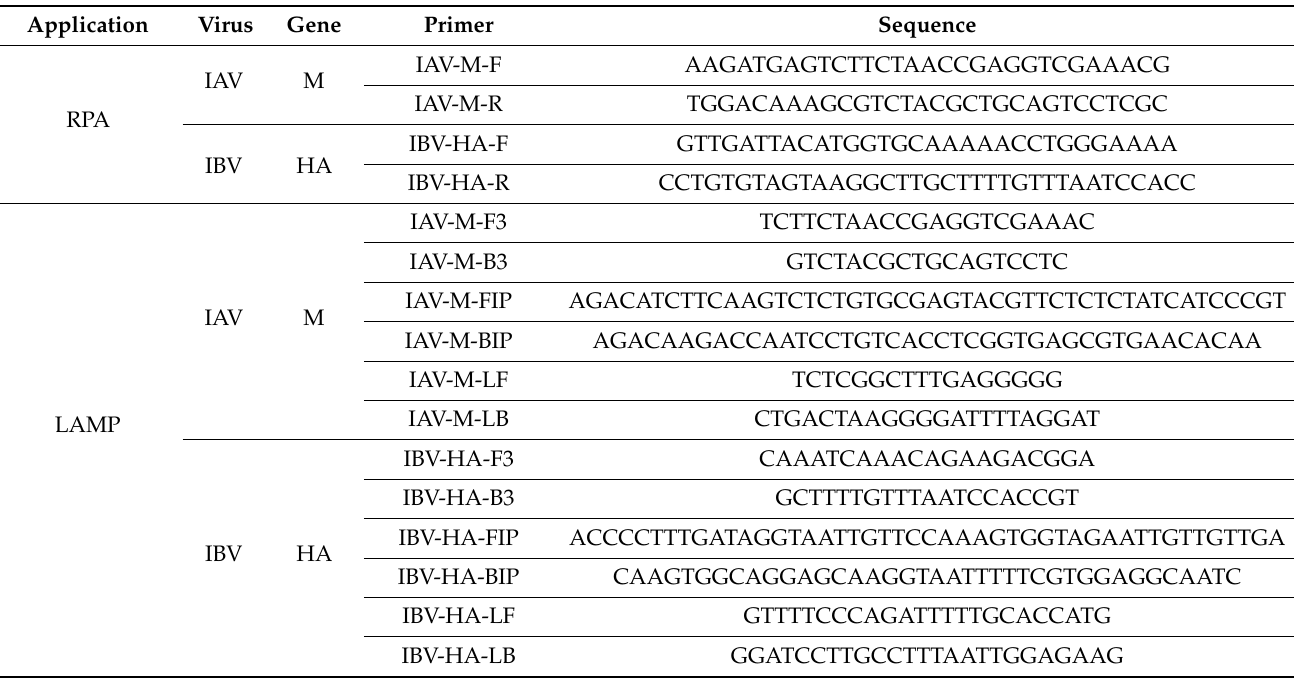
Table 1. Primers for RPA and LAMP.